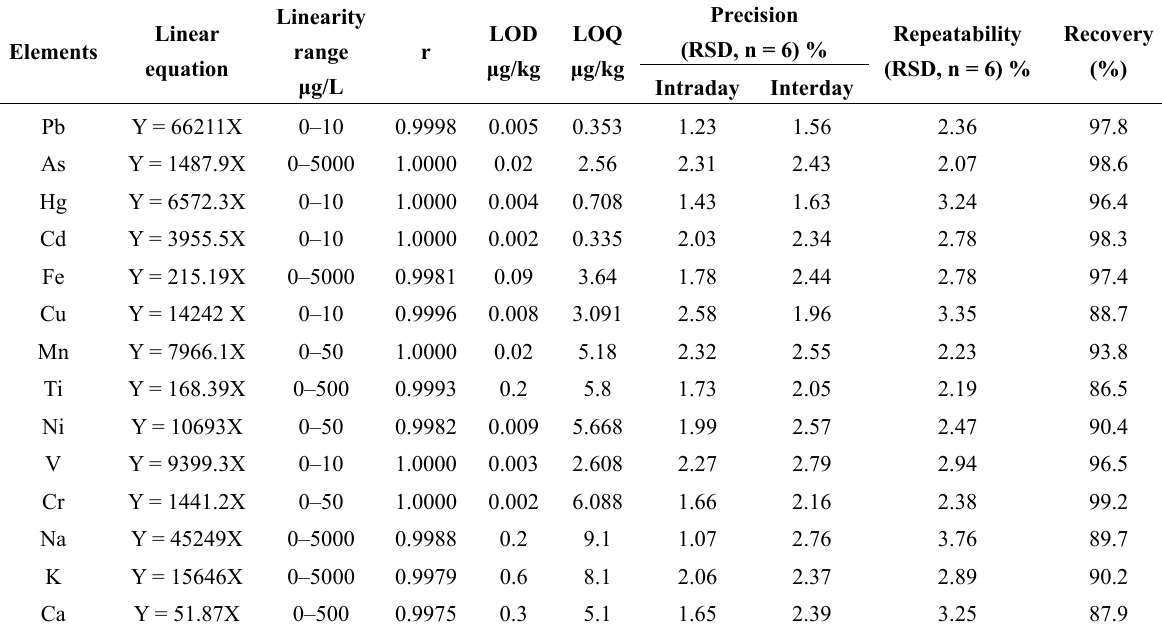
Table 3. The linear regression equations, the correlation coefficient (r), method detection limits (LOD, LOQ), precision, repeatability, and recovery of 14 elements under ICP-MS